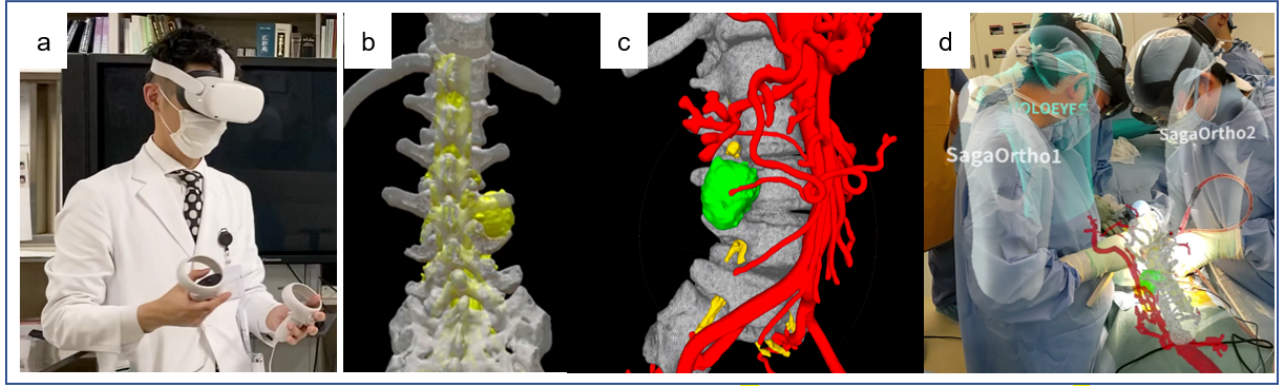
Figure 3. Hologram ‐ based surgical simulation ( a , b , c ) and intraoperative guidance ( d ). ( a ) Resident Figure 3. Hologram-based surgical simulation ( a – c ) and intraoperative guidance ( d ). ( a ) Resident doctor with a head ‐ mounted display. ( b , c ) Relationship between schwannoma and spine and doctor with a head-mounted display. ( b , c ) Relationship between schwannoma and spine and blood blood vessels in a virtual reality environment (Holoeyes XR). ( d ) Hologram ‐ based surgical in ‐ vessels in a virtual reality environment (Holoeyes XR). ( d ) Hologram-based surgical intraoperative traoperative guidance (Holoeyes MD). guidance (Holoeyes